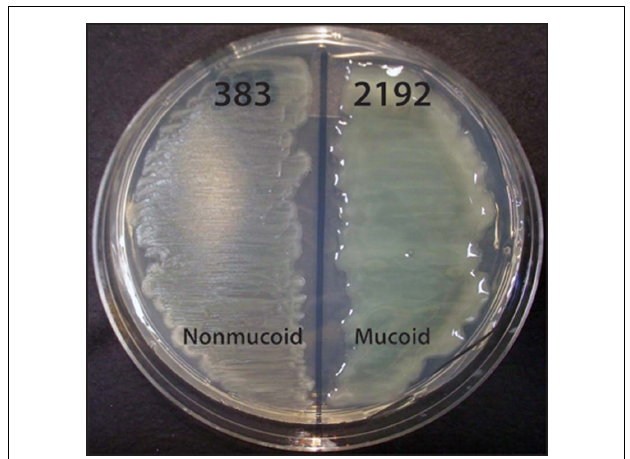
FIGURE 1 | Phenotypes of P. aeruginosa CF isolates 383 and 2192 on L agar media. Streaks of strains 383 and 2192 were cultured on L agar for 24h at 37˚C.These two strains were isolated within 2days apart from a CF patient. Previous data indicated these strains are isogenic (Hanna et al., 2000).The genome of strain 2192 has been sequenced 1 (Mathee et al.,